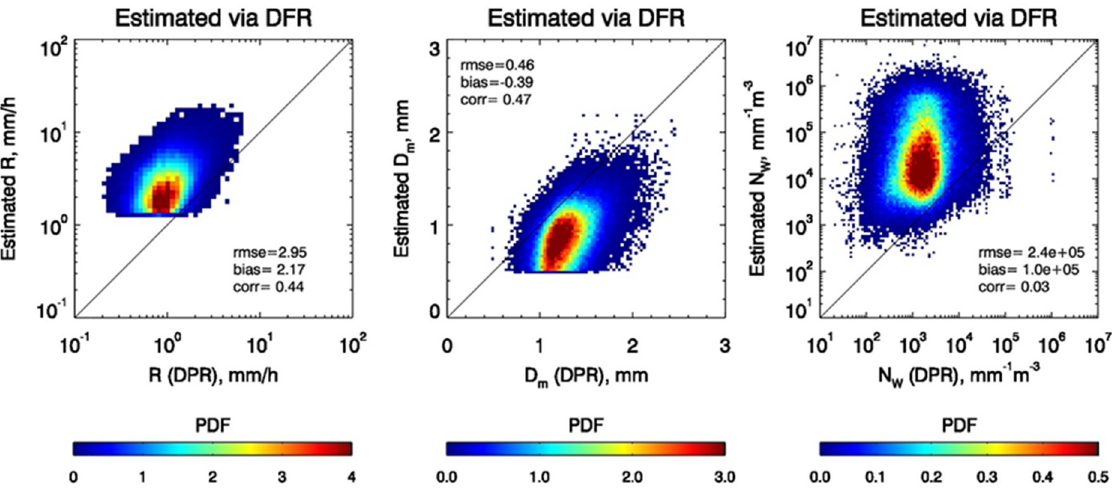
Figure 7. Comparisons of the DFR-estimated R ( left ), D m ( middle ), and N w ( right ) along the ordinate with the same quantities obtained from the DPR products along the abscissa in terms of the PDFs. The rms differences (rmse), biases (bias), and correlations (corr) are provided in the legends.